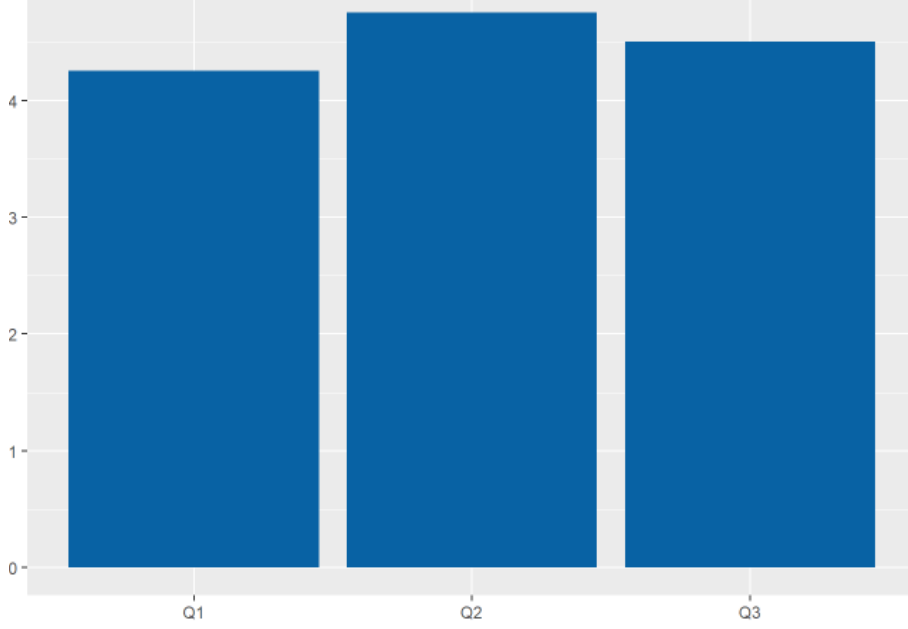
Figure 13. Team 1 user evaluation about the tool.